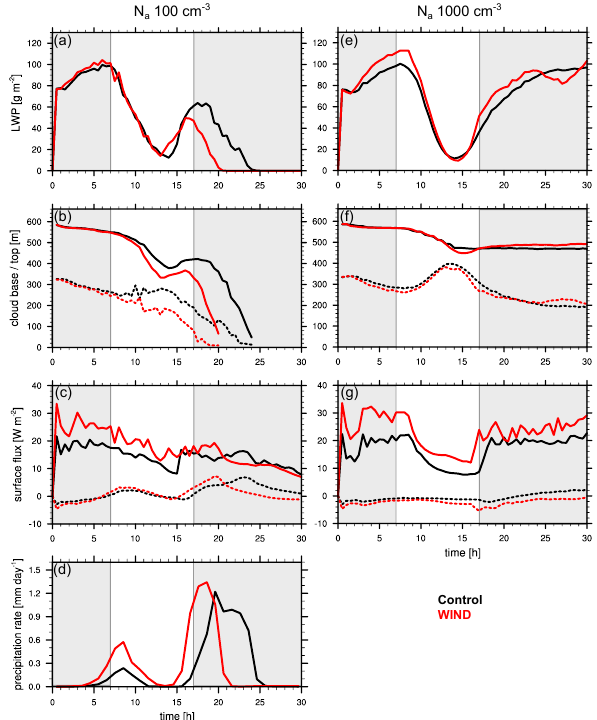
Fig. 10. The same as Fig. 6, except for Control (black) and WIND (red) case.